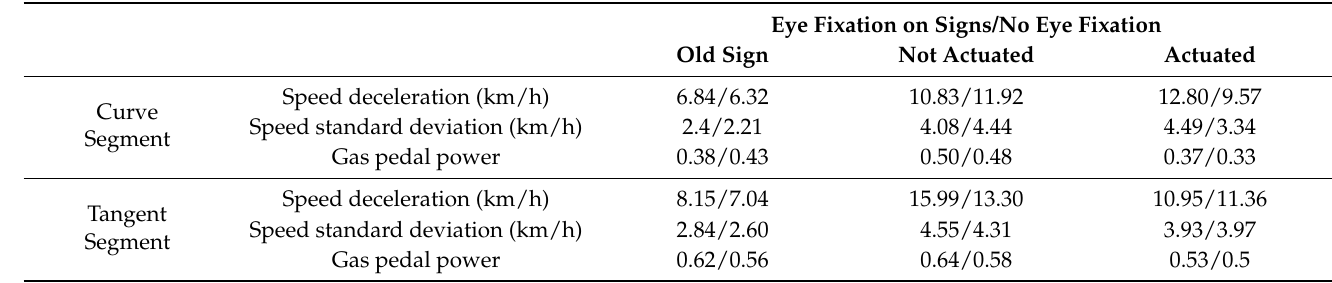
Table 5. Comparison between groups who fixated or did not fixate on